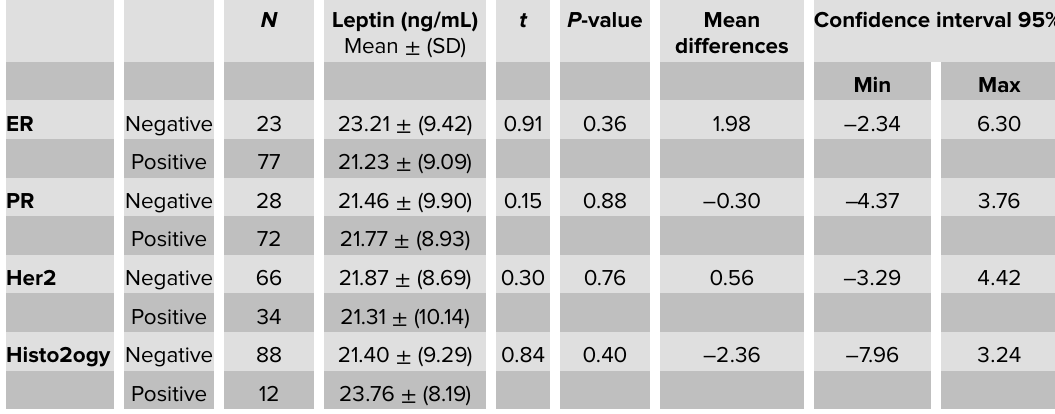
Table 2: Association of leptin level with the status of hormone receptors in the BC